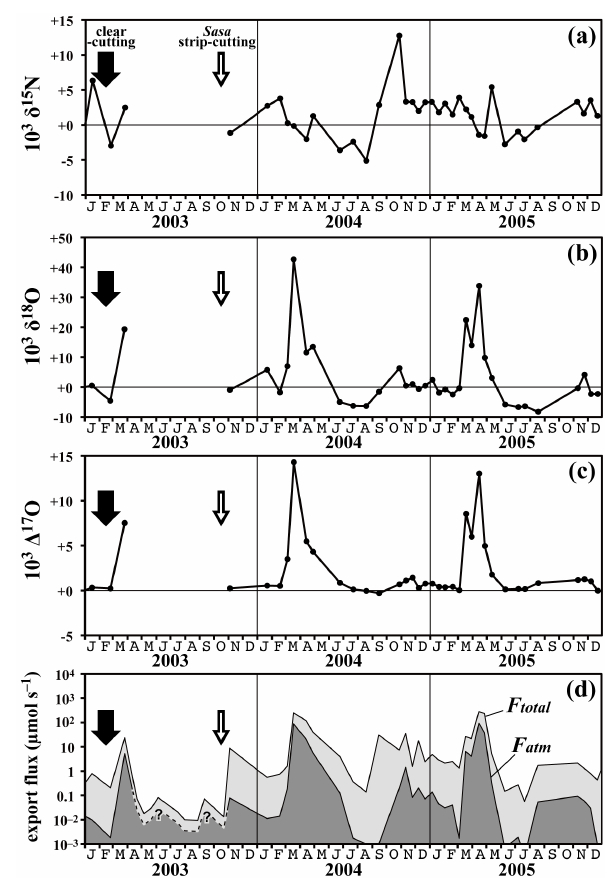
Figure 3. Temporal variations in the values of δ 15 N (a) , δ 18 O (b) , and 1 17 O (c) of nitrate in the stream water, together with those in the export fluxes of nitrate ( F total ) and atmospheric nitrate ( F atm ) on a logarithmic scale (d) . Solid and open arrows denote the period of clear-cutting of trees and strip-cutting of Sasa ,